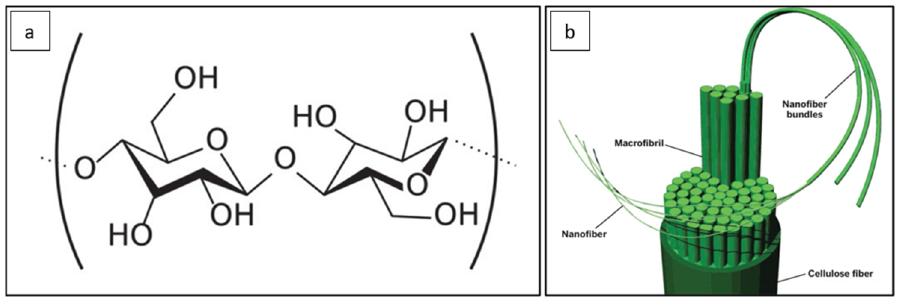
Figure 1. ( a ) Chemical structure of cellulose and ( b ) schematic of nanofibers derived from cellulose fiber (reprinted (adapted) with permission from [8]. Copyright (2015) American Chemical Society).